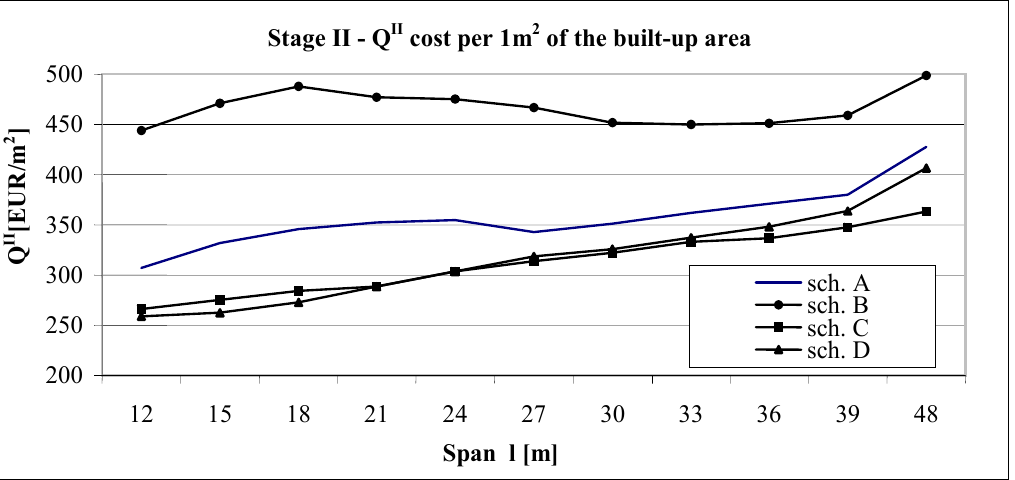
Figure 5. Cumulative cost Q II of stage II per 1 m 2 of the built-up area.